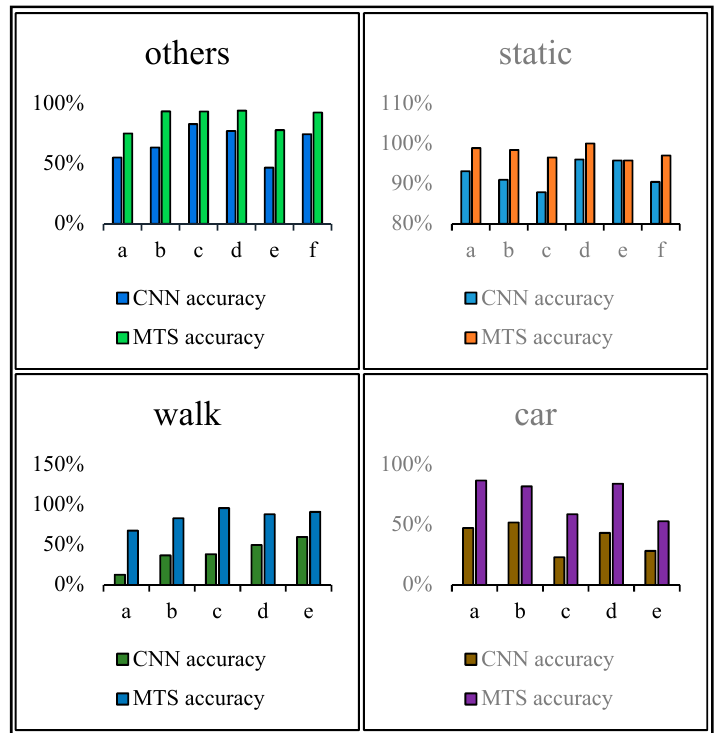
Figure 16. Comparison of the CNN and MTS accuracies.